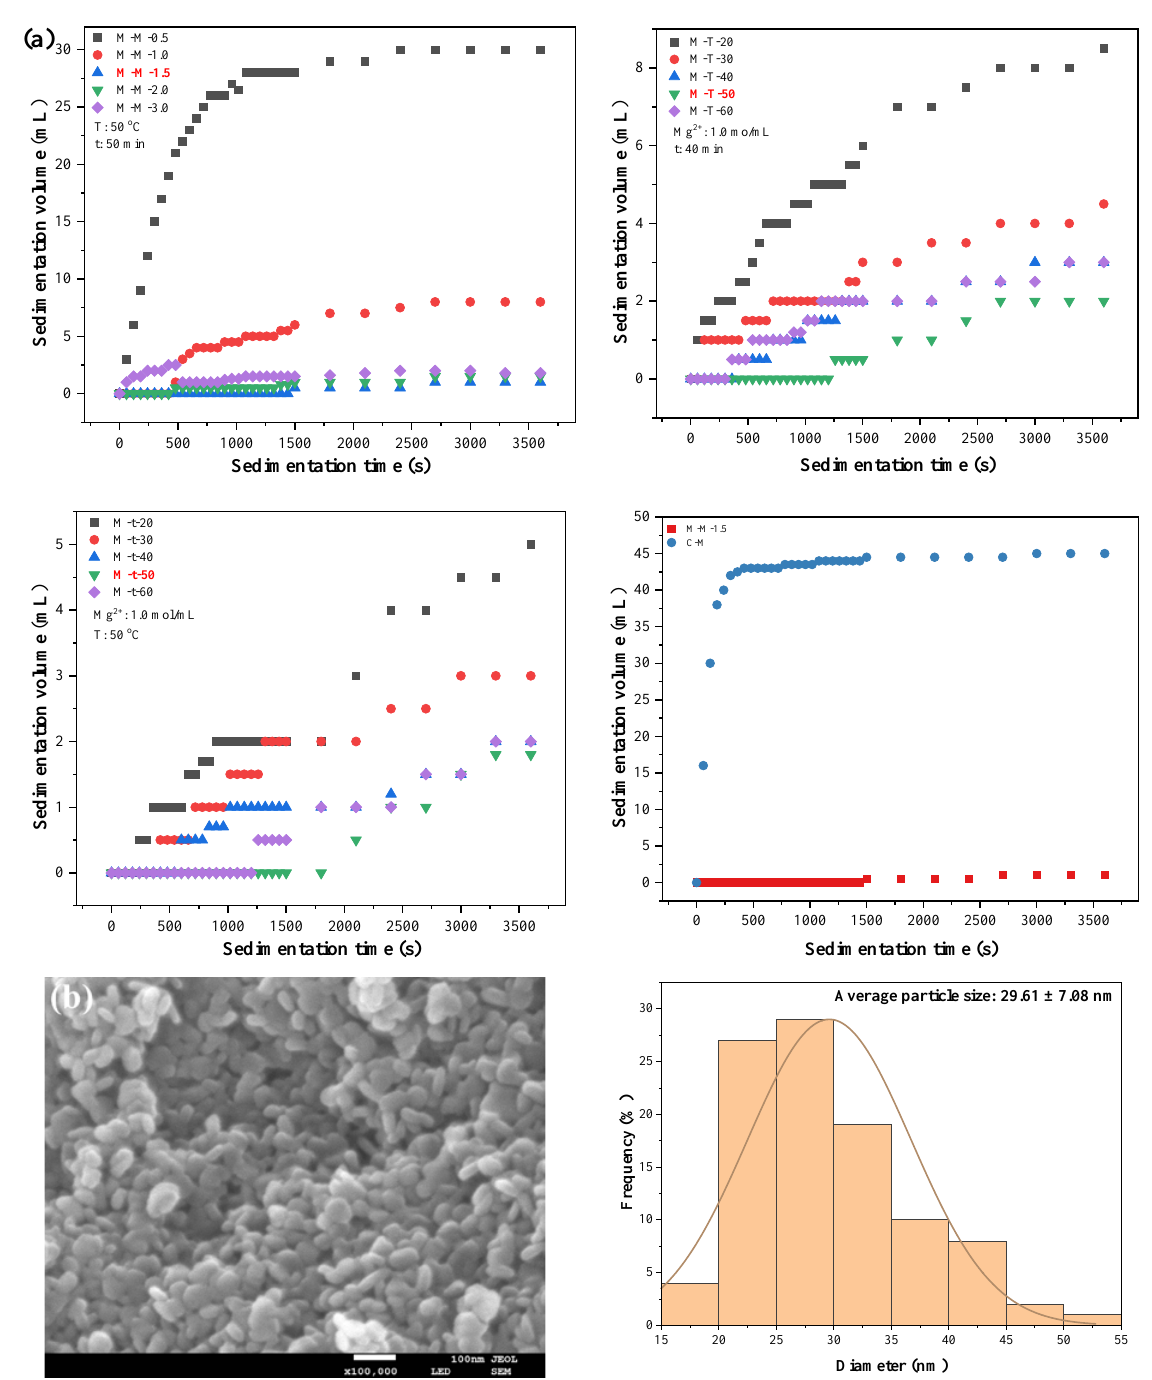
Figure 2. The ( a ) settling rate of synthetic powders and ( b ) SEM image and particle size distribution of M-M-1.5.